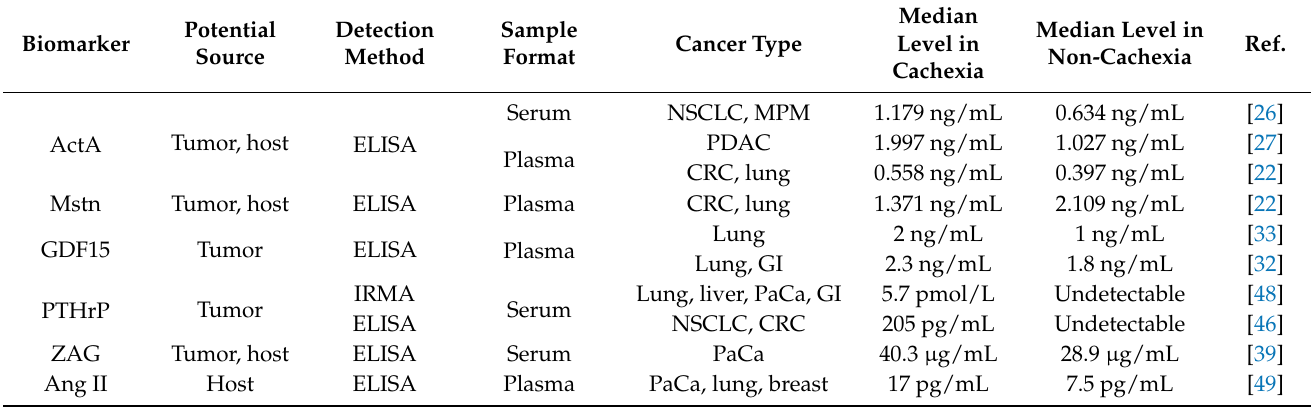
Table 1. Summary of cachexia-inducing factors as potential biomarkers of cancer